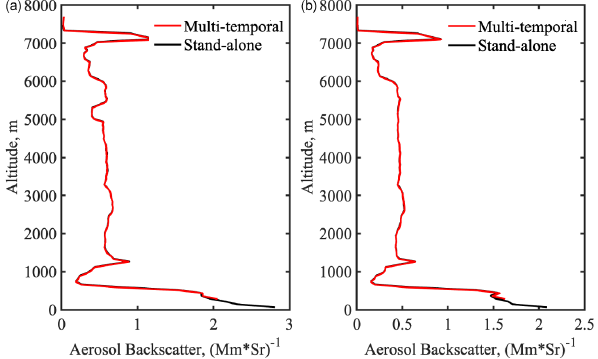
Figure 28. Aerosol backscatter profiles at 455nm (a) and 940nm (b) estimated from COBALD profiles acquired on 12 Au- gust 2016 using a stand-alone (black) and multi-temporal (black) retrieval schemes.